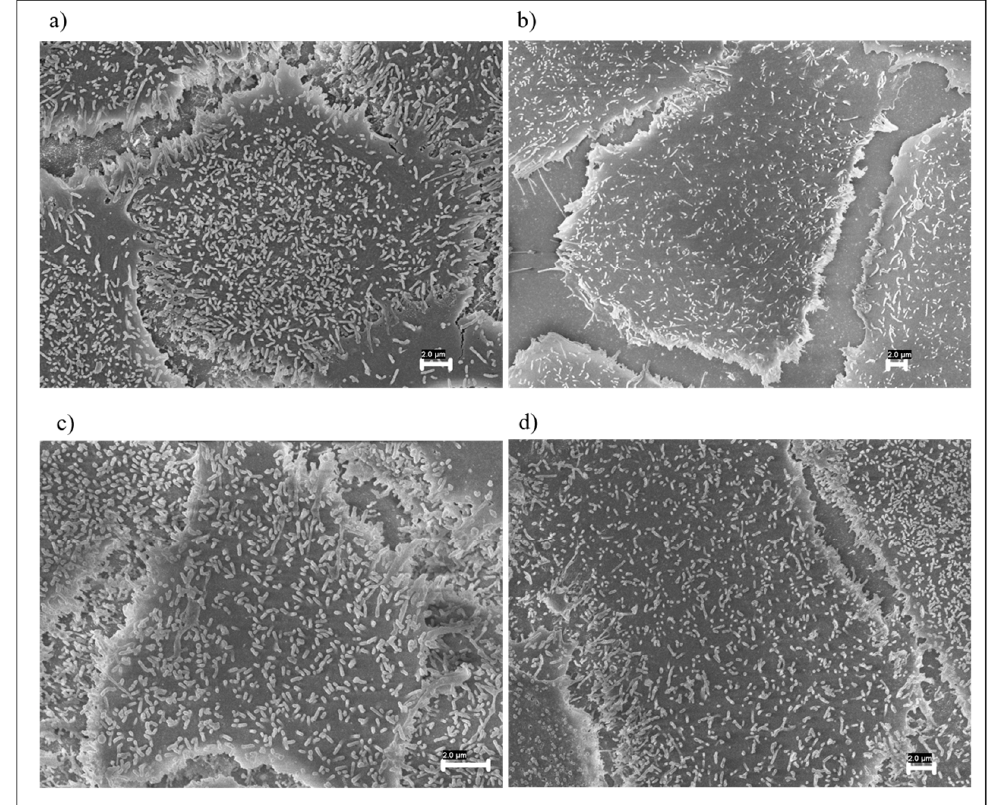
Figure 5. ( a ) FESEM images of control cells (Bar 2 μ m). Cells in contact with different types of fabric: